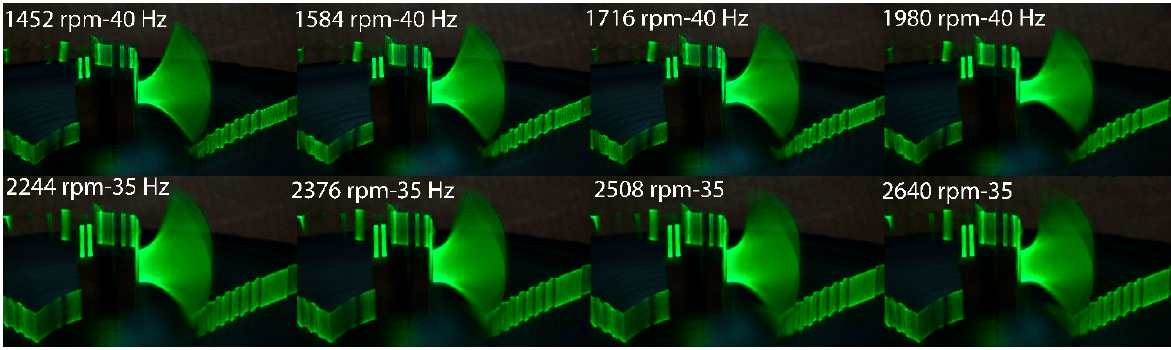
Figure 14. Laser projection of the 4 points with maximum harvested power.